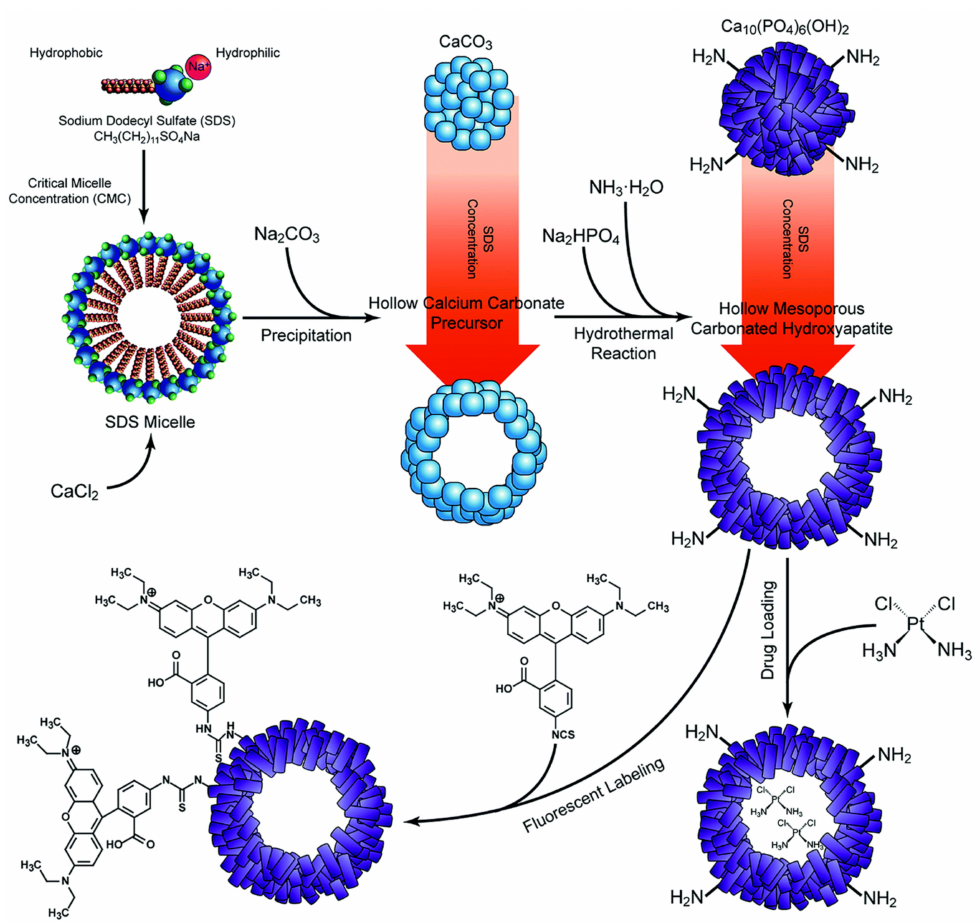
Figure 9. Synthesis of hollow mesoporous carbonated HAp microspheres. Process assisted by SDS for the loading of antitumoral pharmaceutical agents. Image reproduced from [85] with permission from the Royal Society of